Question: Compose a caption that would accompany this figure in a paper.
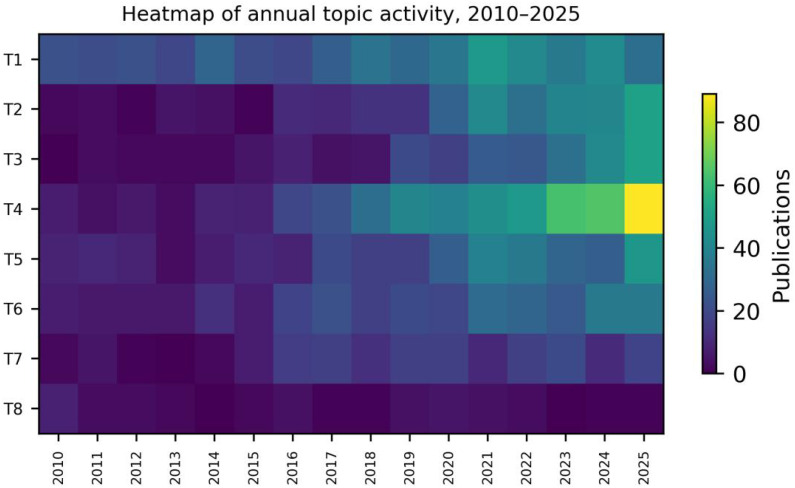
Answer: Heatmap of annual topic activity, 2010–2025. The heatmap presents annual publication activity for each LDA-defined thematic domain. Darker color intensity indicates higher publication activity for a given topic-year combination. This visualization provides an integrated overview of temporal differences among the eight domains and supports the interpretation of recent thematic shifts toward molecular characterization and precision stratification.